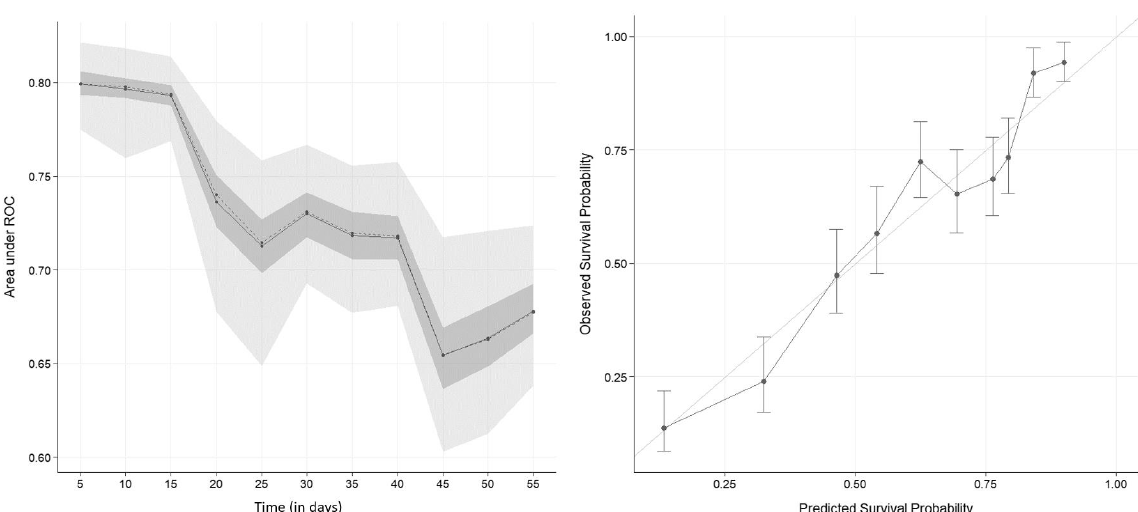
Figure 2. Time-dependent area under the receiver-operator (tAUC) curve (left graph) and calibration curve (right graph) at day 60 of a nomogram predicting survival of dairy cows coming from 124 herds in Québec, Canada with severe clinical mastitis in the 60-day period following a veterinary clinical evaluation. Values were computed based on 100 bootstrap samples. The solid line represents the mean of the tAUC, the dashed line represents the median of the tAUC. The darker interval in the plot shows the 25% and 75% quantiles of the tAUC, the lighter interval shows the minimum and maximum of the tAUC.